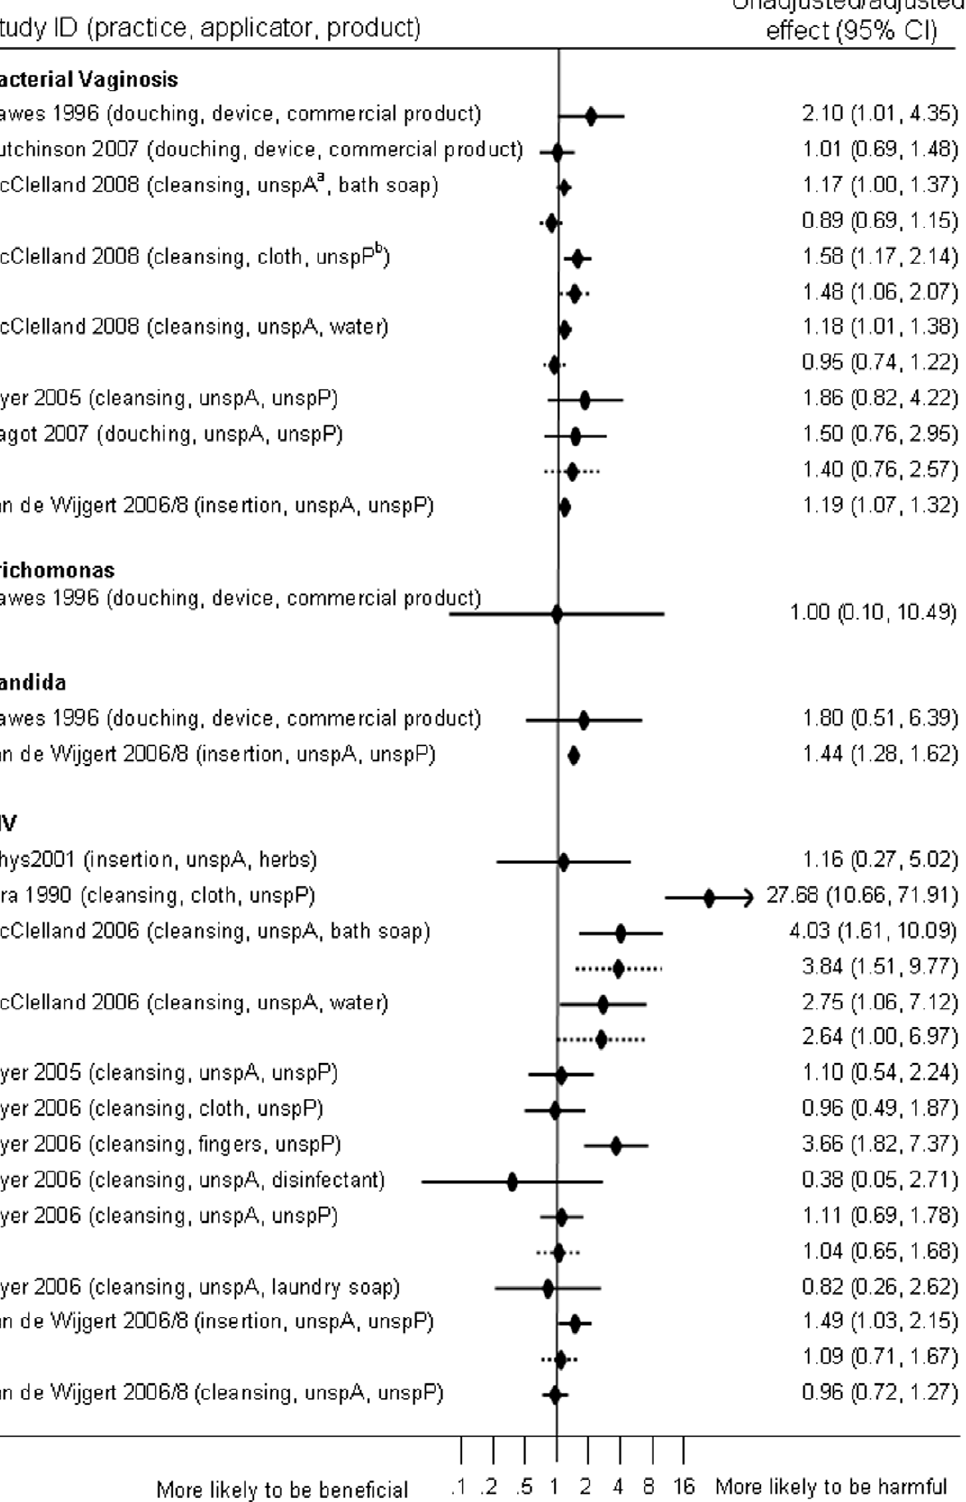
Figure 3. Forest plot of all reported and quantified associations between intravaginal practices and any infection. Forest plot showing unadjusted and/or adjusted effect estimates reported in included studies, according to the infection studied as the outcome. Individual studies can be included more than once if multiple outcomes are reported. If both unadjusted and adjusted effects were reported for the same combination of practice, product and applicator, these are presented with the unadjusted effect estimate above the adjusted effect estimate. No pooled estimates are shown in this plot. Minor differences between effect estimates in the table and those in published papers are possible.